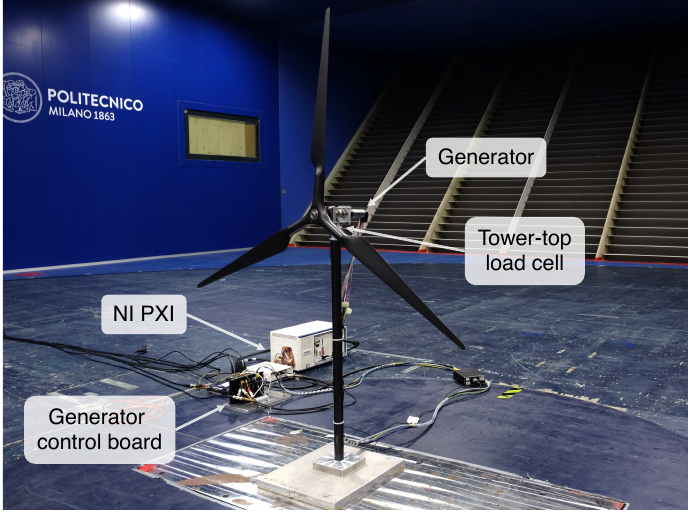
Figure 2. The wind turbine scale model inside the wind